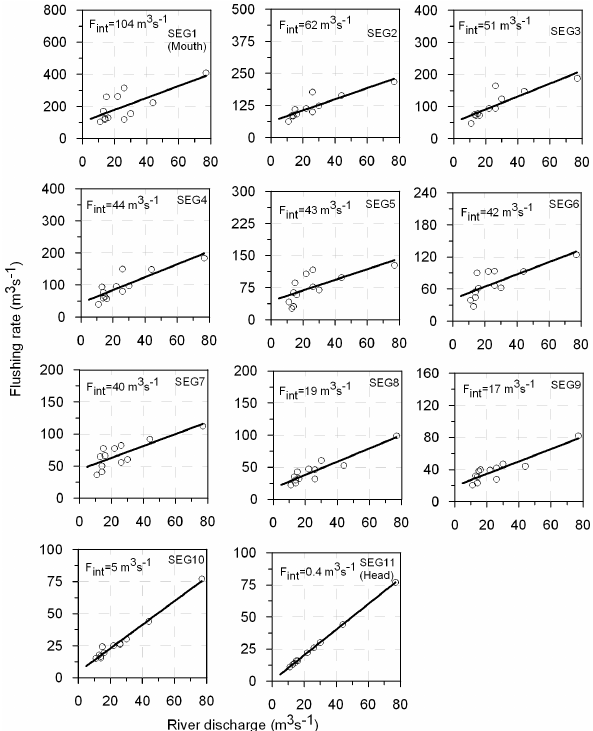
Fig. 10. Plot of the flushing rate ( F ) against the river discharge ( R ) for various segments of the Sumjin River Estuary during neap tide. The intercept value, F int , indicates the tidal exchanges. The amounts in excess of the F int value for various river discharges in- dicate gravitational circulation exchange (here expressed by G c ). Gravitational circulation exchanges entirely dominate at the up- stream